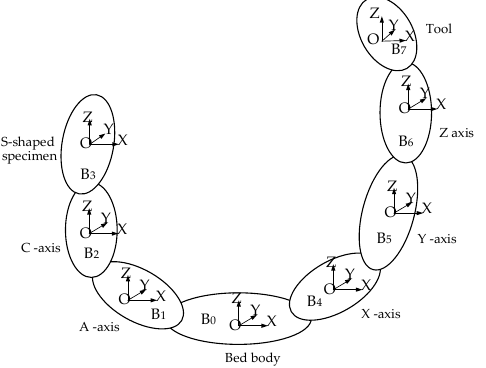
Figure 1. A – C dual turntable five-axis CNC machine structure. B 3 -S-shaped specimen, B 4 -X axis, B 5 -Y axis, B 6 -Z axis, and B 7 -Tool.